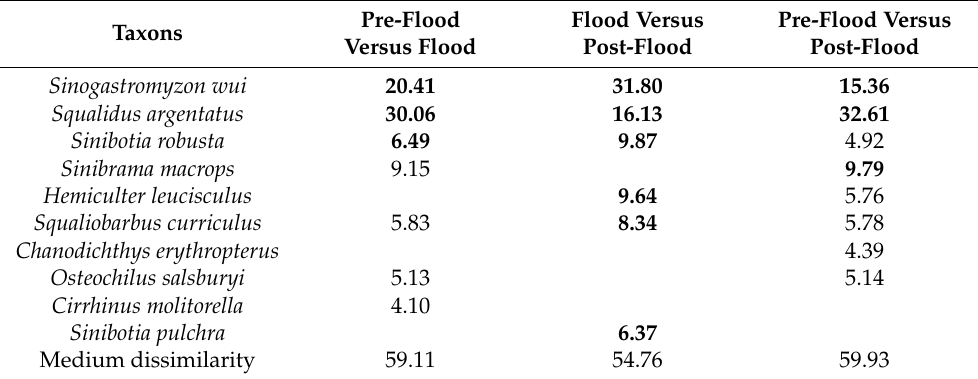
Table 3. Paired comparisons of ichthyoplankton assemblage between periods: Pre-flood, flood, post-flood. The values correspond to the percentage of dissimilarity (similarity percentage (SIMPER) analysis) of the taxa that together contributed to more than 80% of the mean dissimilarity between the periods. The species that contribute the most to the differences are in bold. The grayscale corresponds to changes in the relative abundance of larvae in each section.